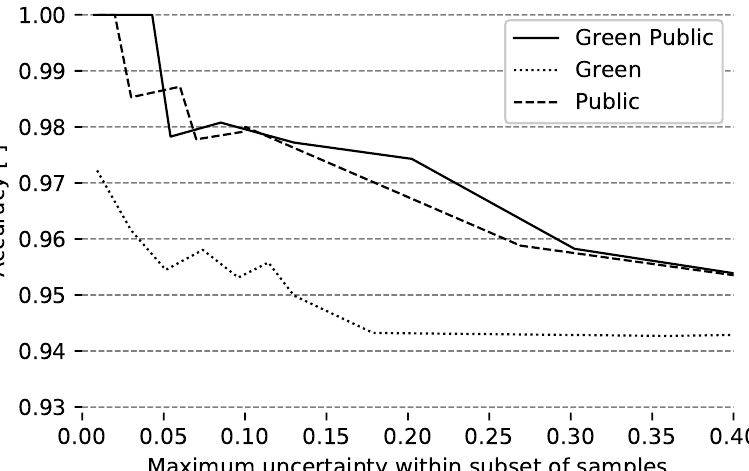
Figure 12. Association between model accuracy and uncertainty of the beliefs. Overall accuracy is shown for subsets of samples ordered by their maximum uncertainty in regard to the beliefs in the greenness, public accessibility and the presence of a public green space. The subsets of samples grow cumulatively along the x -axis, i.e., the sample with the lowest uncertainty is combined with samples of increasing uncertainty along the x